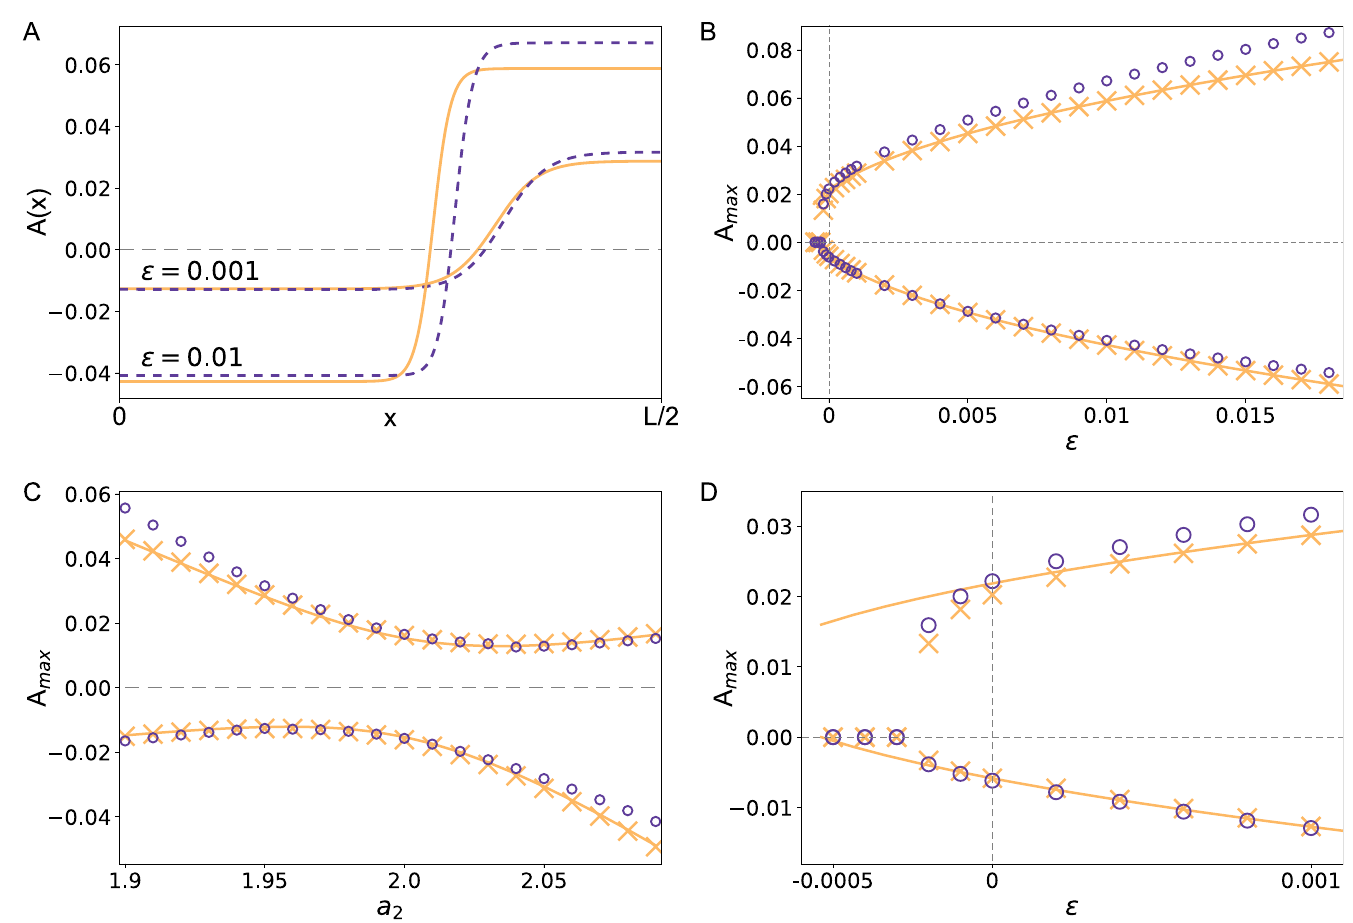
Fig 3. Comparison of steady state solutions of the polarization model and its corresponding CH model in the asymmetric case. (A) Steady state profiles for a 2 N = 1.95 and two values of ε = 0.001 and ε = 0.01 for both the basic polarization model in Eqs (1) and (2) with A ð x Þ ¼ ð v ( x ) of the CH model in Eq (30) (solid lines). (B), (D) Plateau values of the steady state profiles shown in (A) from simulations of the basic polarization model (purple circles) and the reduced CH model (yellow crosses) as a function of ε . The yellow solid line is an analytical approximation for the plateau values of the CH model given by Eq (37). (D) is a close-up around ε = 0 that shows the subcriticality of the bifurcation. (C) Plateau values of the steady state profiles for simulations of the polarization model (purple circles) and the reduced CH model (yellow crosses) as a function of the asymmetry parameter a 2 . The yellow line depicts again an approximation via Eq (37).